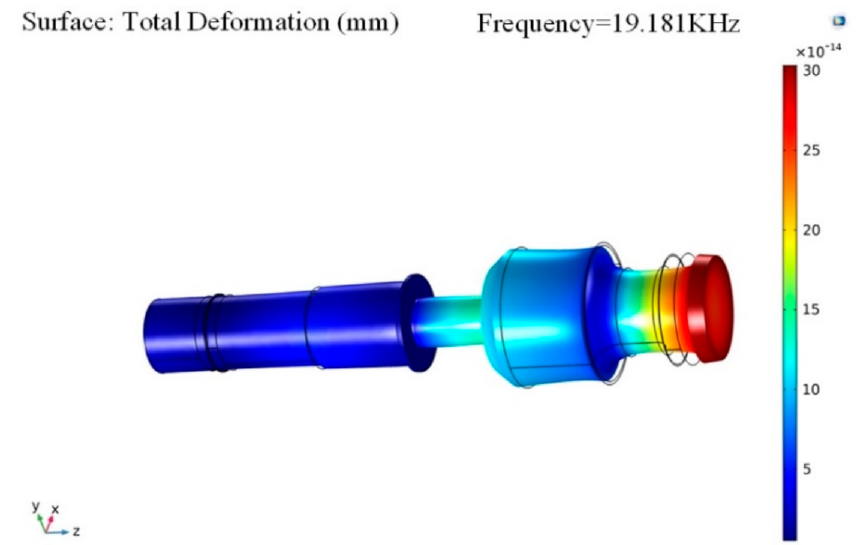
Figure 3. Modal analysis of the ultrasonic vibration system.